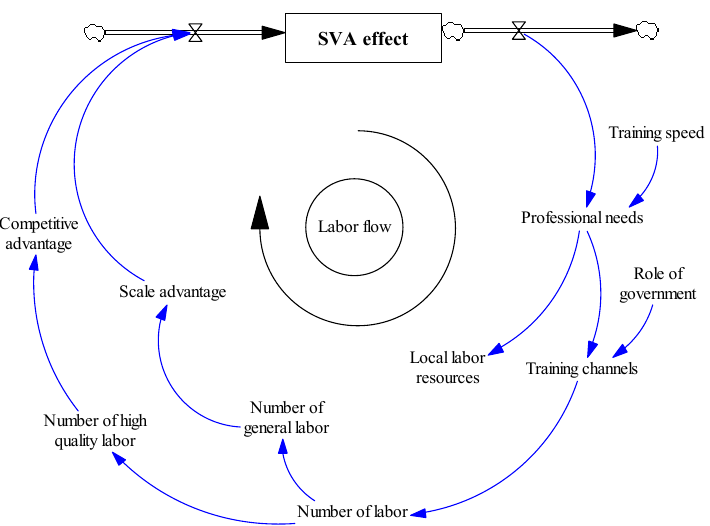
Figure 2. Labor flow causality. Arrows indicate causality; Clockwise arrow indicates positive feedback.